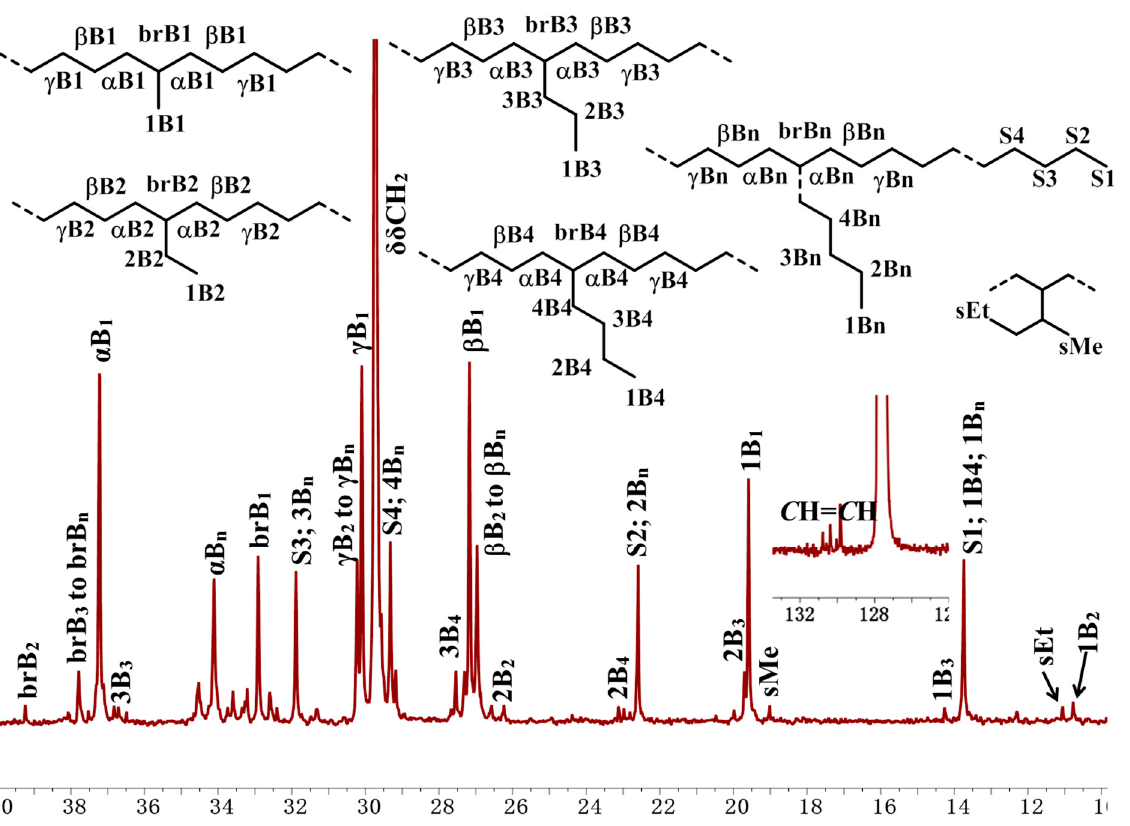
Figure 3. Detailed analysis of 13 C NMR spectrum (C 6 D 6 ) of the hyperbranched oligomer sample from entry 2, Table 1. Assignments are labeled by reference